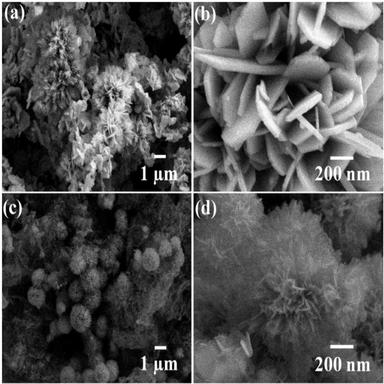
(a, b) FESEM images of VSe2 nanosheets; (c, d) FESEM images of rGO-VSe2 nanohybrid at different magnifications.